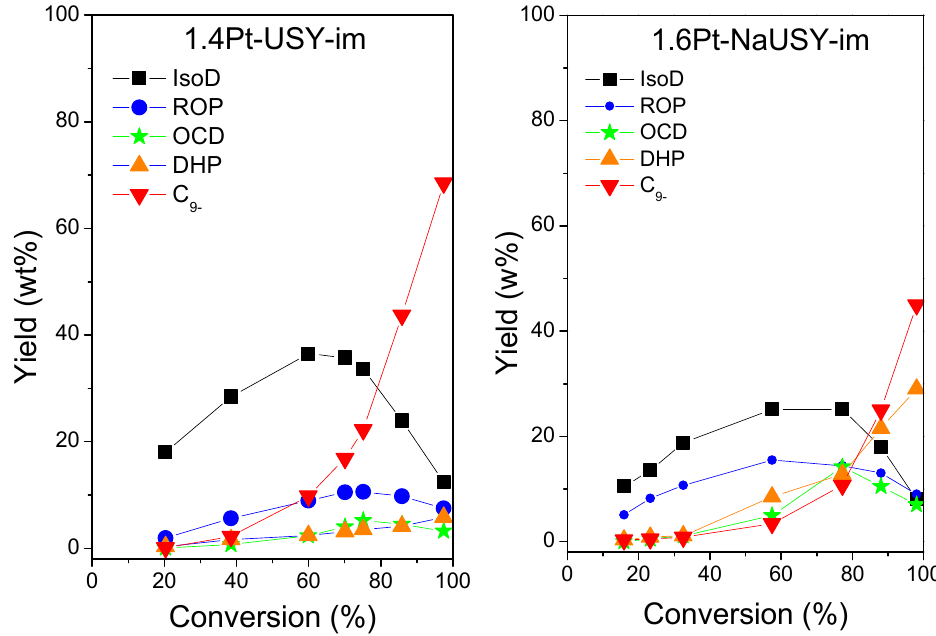
Figure 3. Product yields (wt%) vs. decalin conversion (%) obtained for 1.4Pt-USY-im and 1.6Pt-NaUSY-im catalysts. Reaction conditions: T = 300–390 ◦ C, WHSV = 3.22 h − 1 , P = 35 bar, and H 2 / D = 100. Table 4. Maximum yields of OCDs obtained for 1.4Pt-USY-im and 1.6Pt-NaUSY-im catalysts.